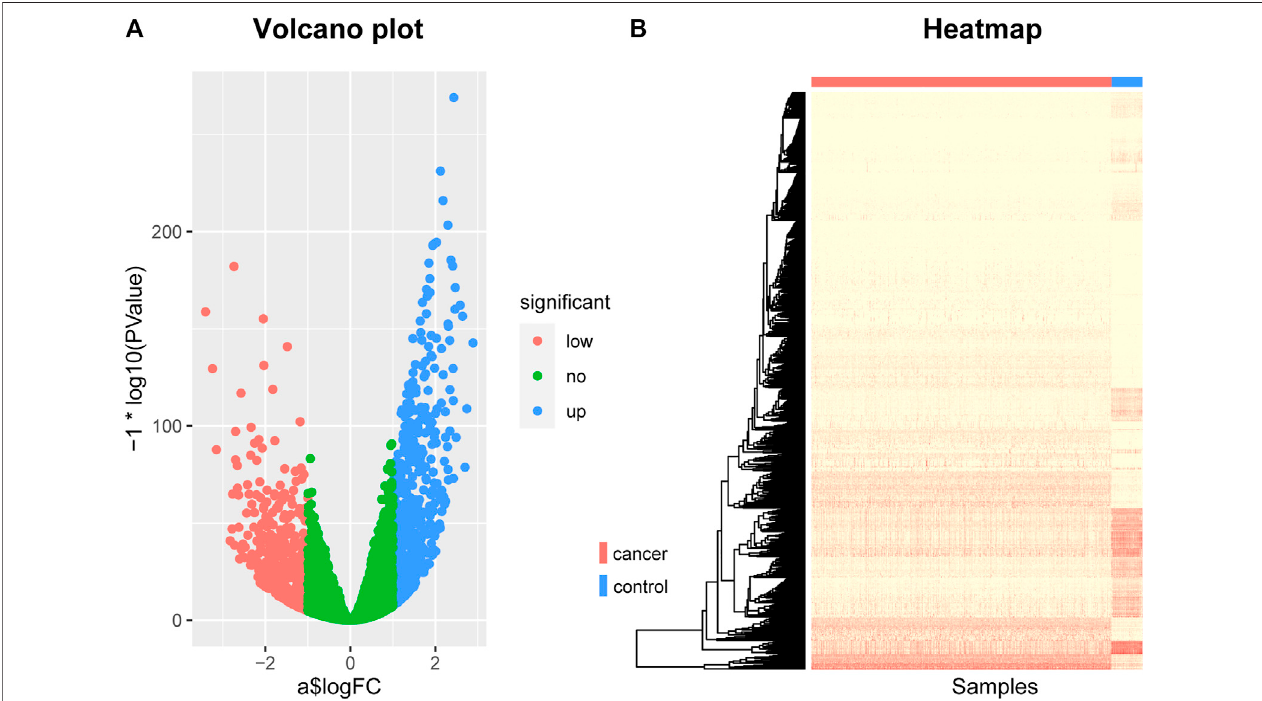
FIGURE 1 | The Volcano plot and Heat map of differentially expressed genes. (A) The Volcano plot of differentially expressed genes, where the red dots represent the genes that are down-regulated in breast cancer, the blue dots represent the genes that are up-regulated in breast cancer, and the green dots represent the genes that are not signi fi cantly different. (B) The Heat map of differentially expressed genes. The rows represent differentially expressed genes and the columns represent patients, where the red bar represents breast cancer patients and the blue bar represents normal control samples.